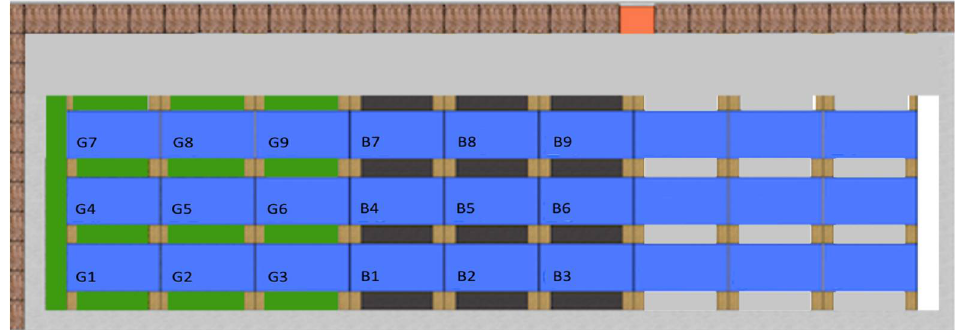
Table 1. PV module electrical features.